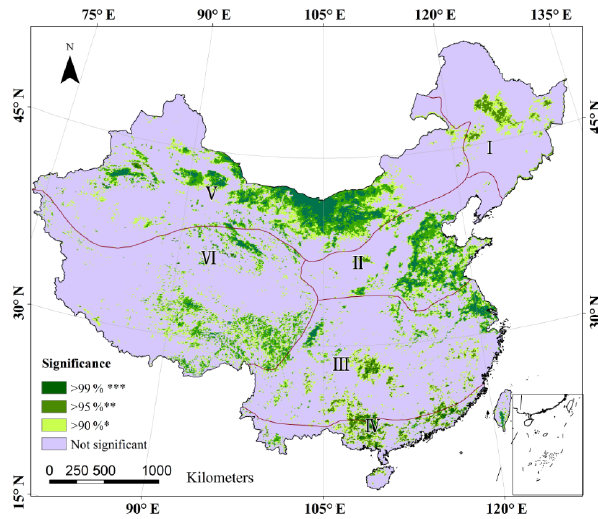
Figure A1. Significance of the spatial distribution of annual av- erage LST trends based on an independent-samples t test in China from 2003 to 2017. Note that the symbols ***, ** and * explain that there are increasing or decreasing tendencies averaged over China at the 99%, 95% and 90% confidence level, respectively (same as Figs. A3 and